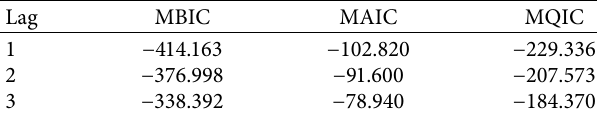
Table 2: Lag order selection criteria. Table 1: Reports the definitions of the variables we used, the data